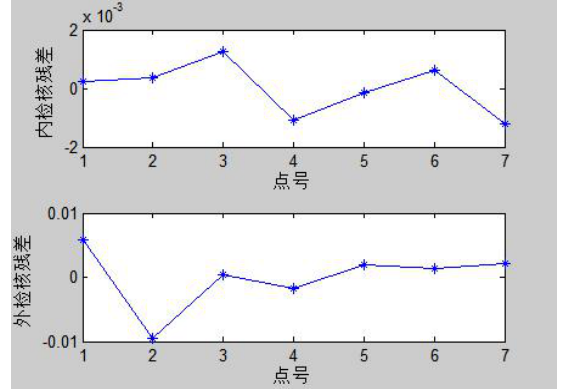
Figure 3 Fitting internal and external check residual distribution map